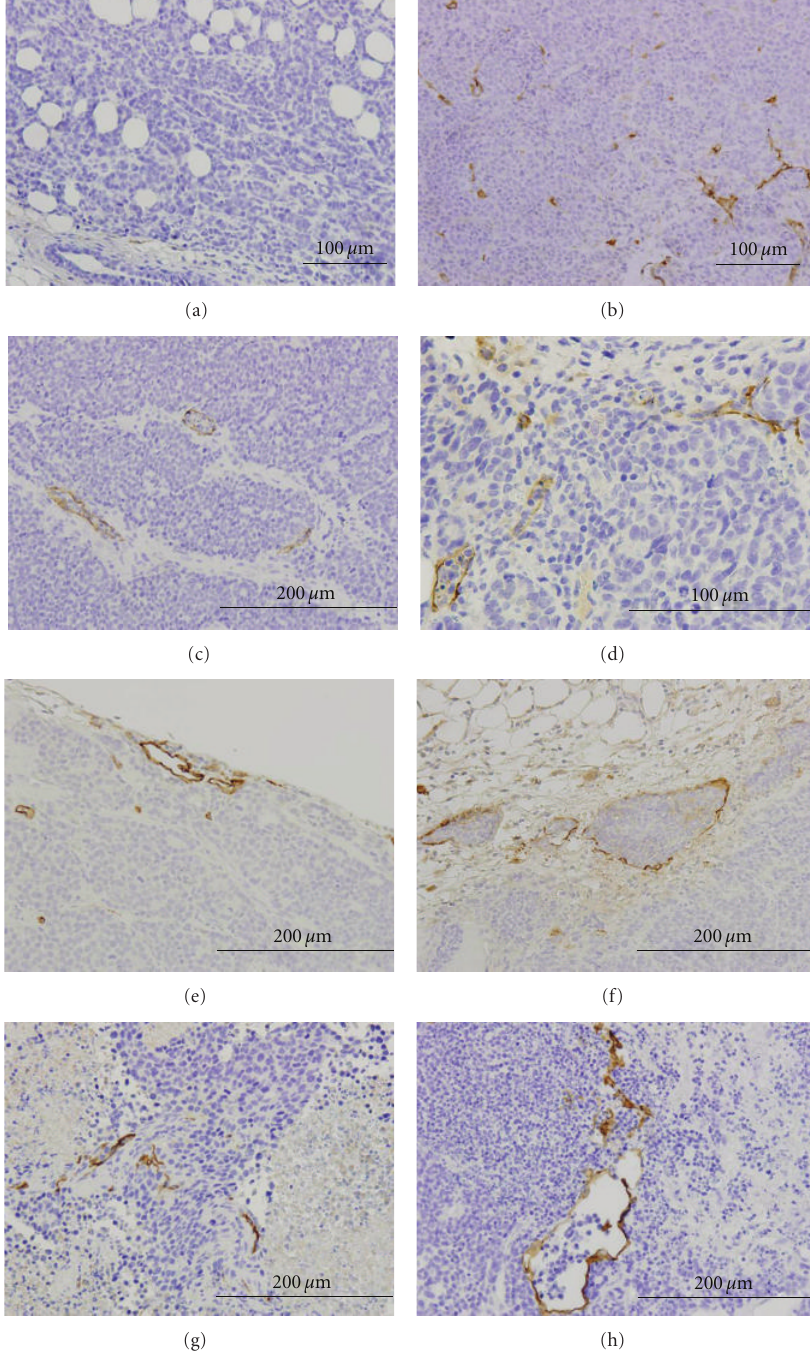
Figure 4: Immunohistochemistry of LYVE-1 in BJMC338 tumors (a, c, e, and g) and BJMC3879 tumors (b, d, f, and h) at 4 weeks (a and b), 6 weeks (c and d), 8 weeks (e and f), and 10 weeks postinoculation (g and h). Note the upregulation of LYVE-1 in BJMC3879 tumors.